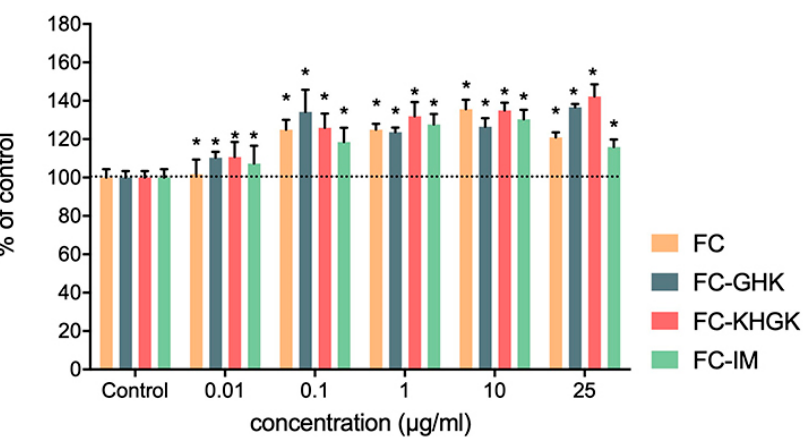
Figure 11. Effect of tested peptides on collagen synthesis in 46BR.1N fibroblasts. The graph shows results from three independent experiments. Results are presented as mean with SEM. *-